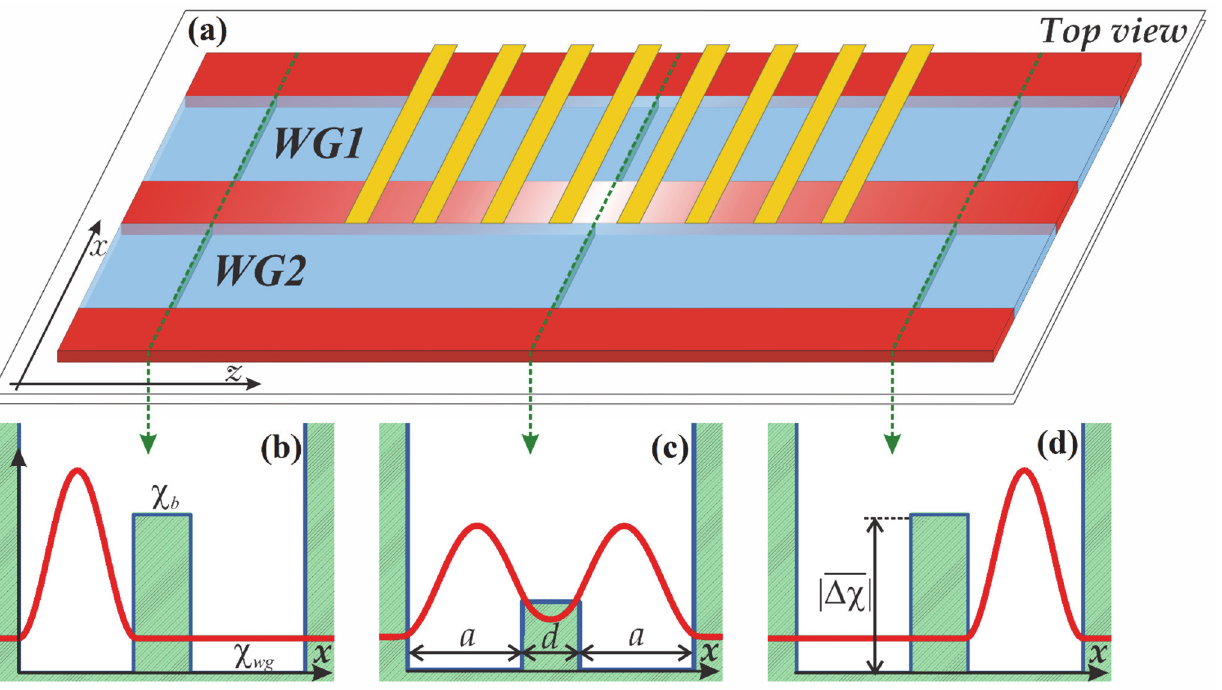
Figure 1. ( a ) The schematic top view of the two coupled planar waveguides ( a ) with additional control of the susceptibility in the middle part of the interwaveguide area (the yellow stripes illustrate the electrodes controlling the degree of doping in this area). In the framework of the optical-mechanical analogy, such a structure corresponds to the double-well potential ( b – d ). Plots ( b , d ) correspond to the switched-off tunnel transparency of the interwaveguide area, while the transparency is switched on for the plot ( c ). The red curves here are the snapshots of the initial/final field distribution ( b , d ) as well as field distribution during the tunneling ( c ).